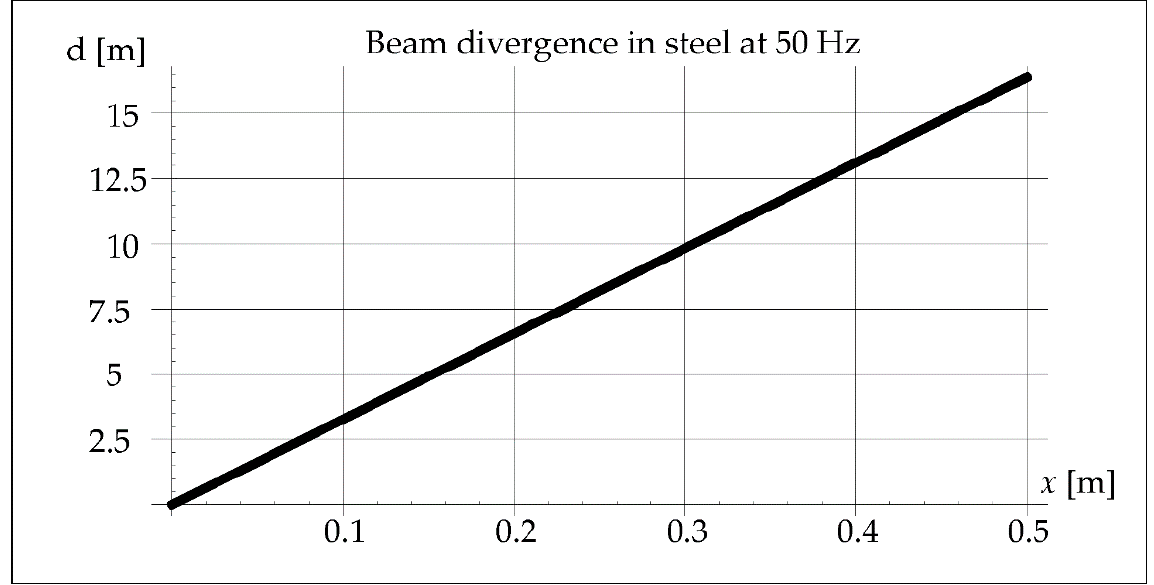
Figure 6. Beam divergence in steel at 50 Hz.